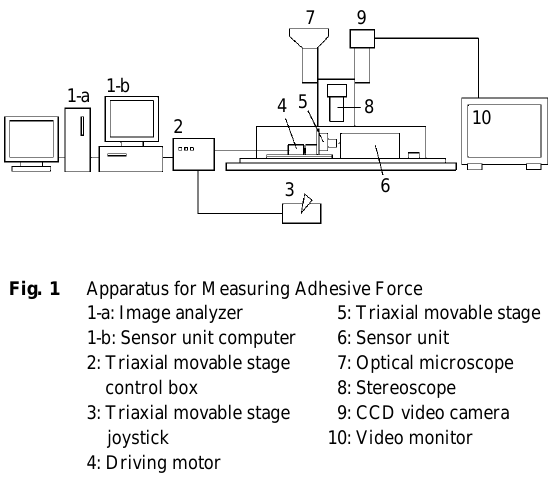
a CCD video camera (9). A detailed view of the sensor (6-b) that comes into contact with the sample and dis- lodges particles, two plate springs (6-a) connected to the needle, and a laser displacement gauge (6-c)